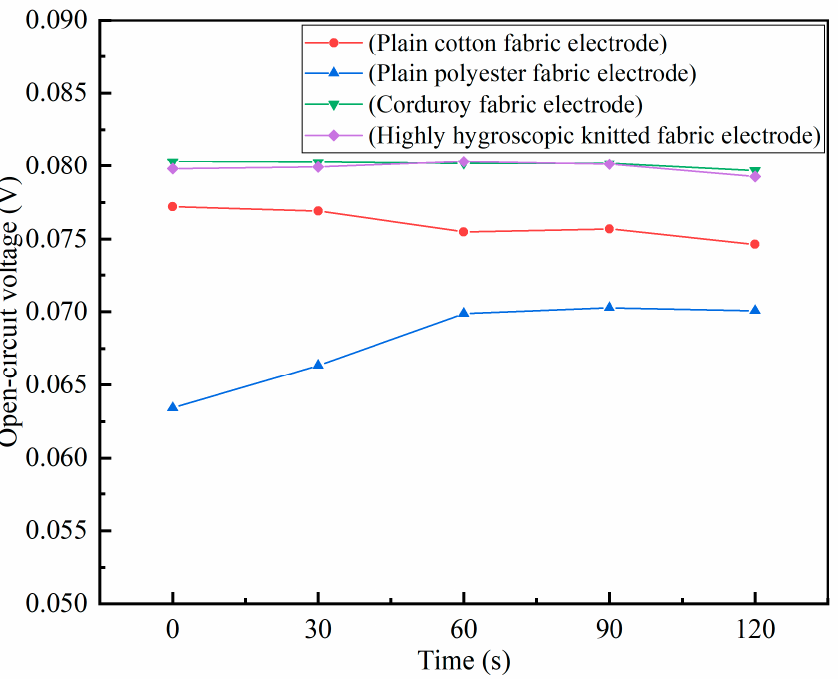
Figure 7. Static open-circuit voltage of four fabric electrodes.